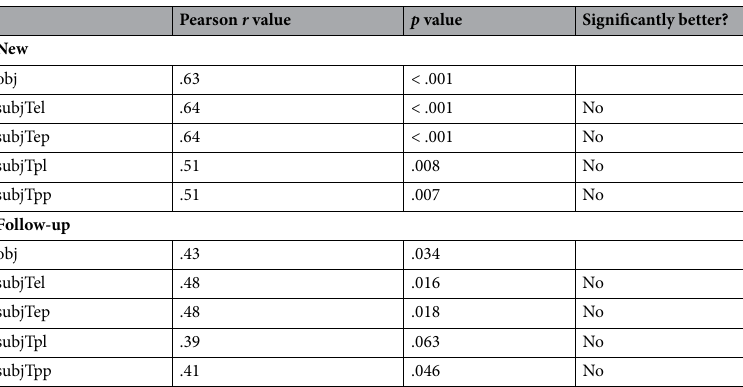
Table 2. Pearson correlation between log ( k SV ) and log ( k LV ) . ‘Significantly Better?’ answers whether there has been a significant increase in correlations from the objective time model to the respective subjective time model tested using R package cocor (“Methods”). After accounting for subjective timing in the short delay task we hypothesized to find a higher correlation between discount factors in the short and long delay tasks. However, although we found stronger correlations none of them resulted in significant increase, thus, not supporting our third